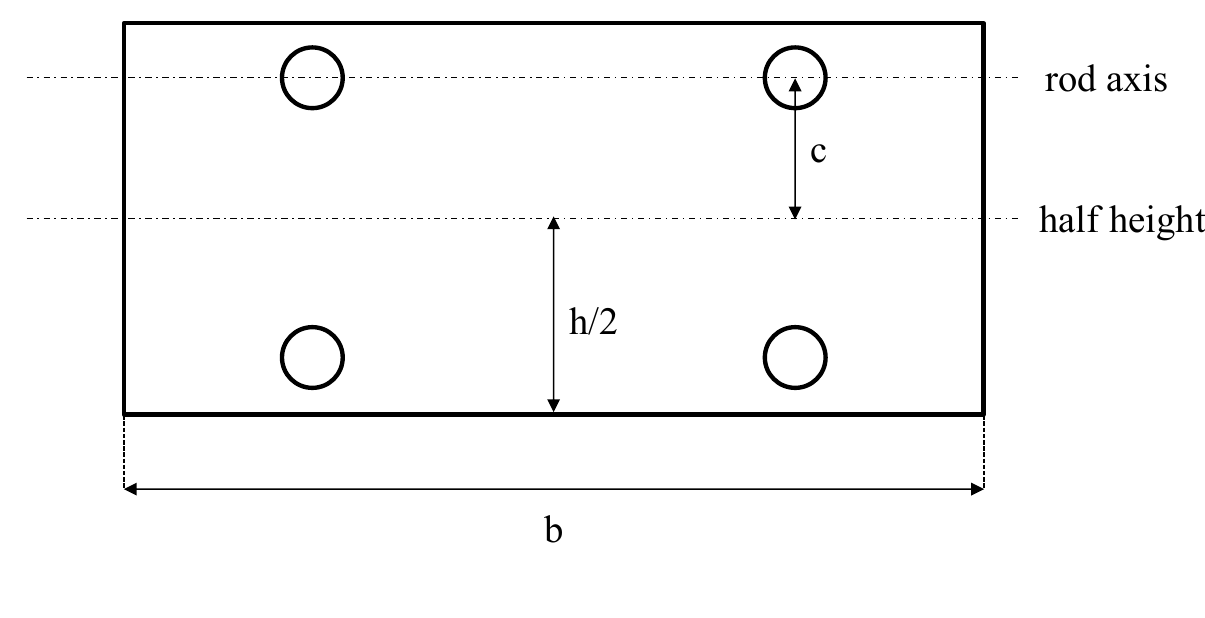
Figure 1. Layout of reinforcing